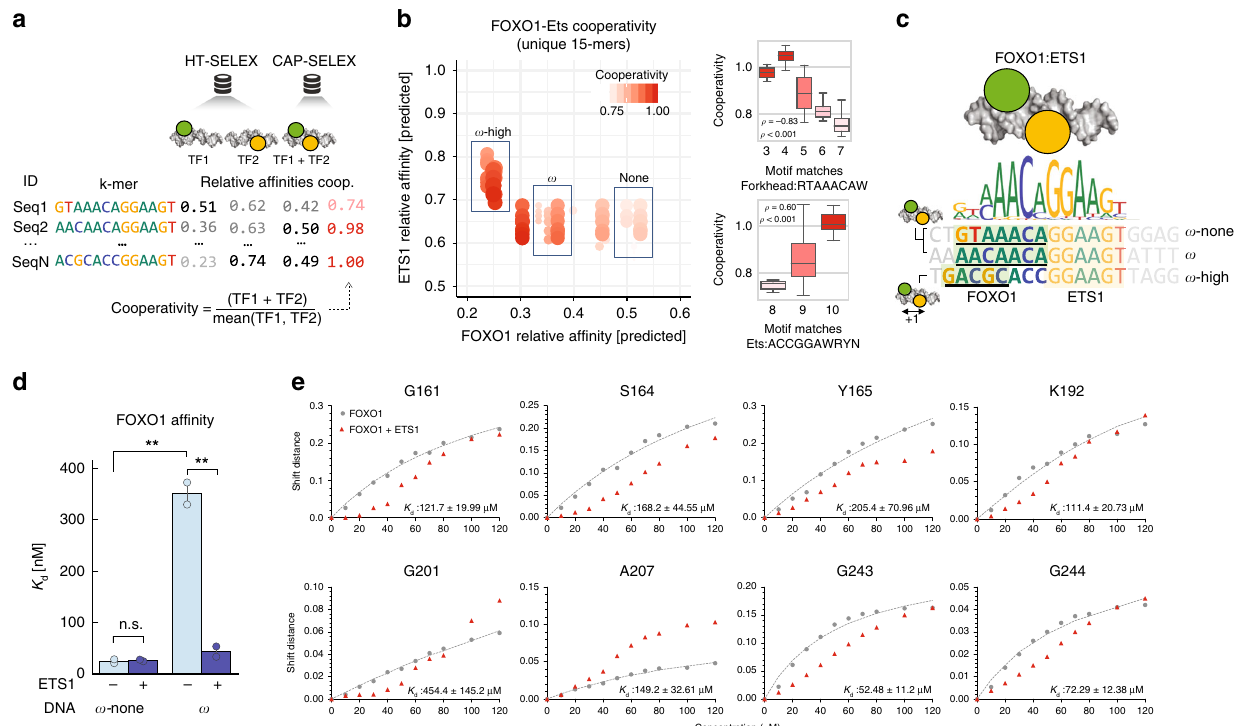
Fig. 2 Prediction and validation of cooperative binding sites from SELEX data. a Work fl ow describing the calculation of the cooperativity potential between k -mers from CAP-SELEX and matched HT-SELEX data. Predicted relative af fi nity values of k -mers from CAP-SELEX data are scaled by the mean value observed in HT-SELEX for the matched single TF datasets. b Comparison of relative af fi nity predictions for ETS1 and FOXO1 for 15-mers using HT- SELEX (left). K -mers are weighted by their estimated cooperativity potential using CAP-SELEX of FOXO1:ELK1 and HT-SELEX datasets for FOXO1 and ETS1 (ELK1 paralogue). Y -axis and X -axis indicate predicted relative af fi nities for ETS1 and FOXO1 datasets, respectively, using 1mer + shape models. Correlations between number of motif matches between Forkhead or Ets consensus k -mer and CAP-SELEX k -mer in assessed region and cooperativity for Forkhead and Ets binding sites in 15-mers (right). ρ and p indicate Spearman ‘ s rho and signi fi cance, respectively. c Cartoon description of binding mode for the FOXO1- ETS1 ternary complex (top). Sequences chosen for validation from regions of none ( ω -none), moderate ( ω ) and high ( ω -high) cooperativity are shown and aligned with Forkhead-Ets composite motif (bottom). Green and yellow highlighted regions indicate Forkhead and Ets binding regions, respectively. Underlined regions for ω -none and ω -none indicate Forkhead motifs, and underlined ω -high region indicates a FHL site 22 with a spacing increased by one base pair ( + 1) between Forkhead and Ets DNA-binding domains (Supplementary Fig. 2). d Dissociation constant ( K d ) ITC measurements for FOXO1 with ω -none and ω DNA sequences in the absence and presence of ETS1 (ns = non-signi fi cant, ** t -test p -value < 0.01). e Titration curves of FOXO1 binding to ω -high using different N – H peaks, without (gray dots) and with ETS1 (red triangles). The gray line indicates the titration fi t without ETS1. The different binding af fi nities for each residue are highlighted in the bottom-right of each panel (± = one standard